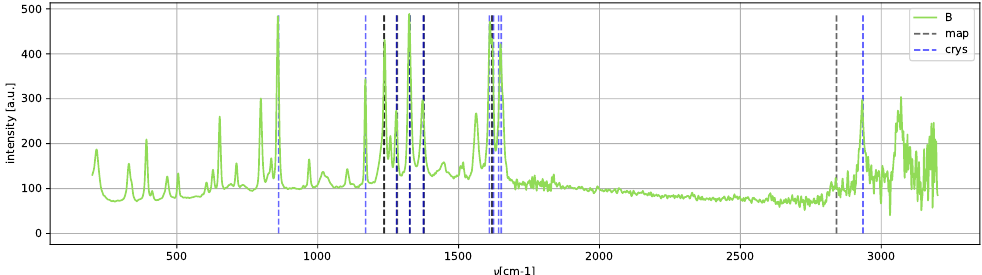
Figure 13. Spectrum A , metastable amorphous phase in presence of solvent.